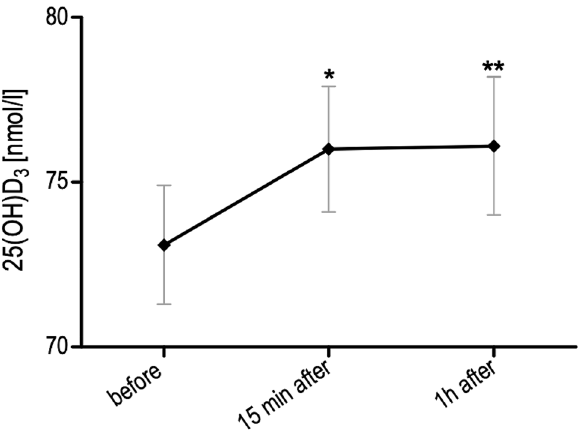
Figure 1. The concentration of 25(OH)D 3 before, 15 min after and 1 h after a single bout of exercise (both VO 2max and WAnT tests) in boys n = 26 (10–14 years). Results were expressed as mean ± SEM. *p = 0.016— difference between indicated result/mean and the results before, **p = 0.011—difference between indicated result/mean the results before, LSD post hoc test after repeated measures ANOVA.